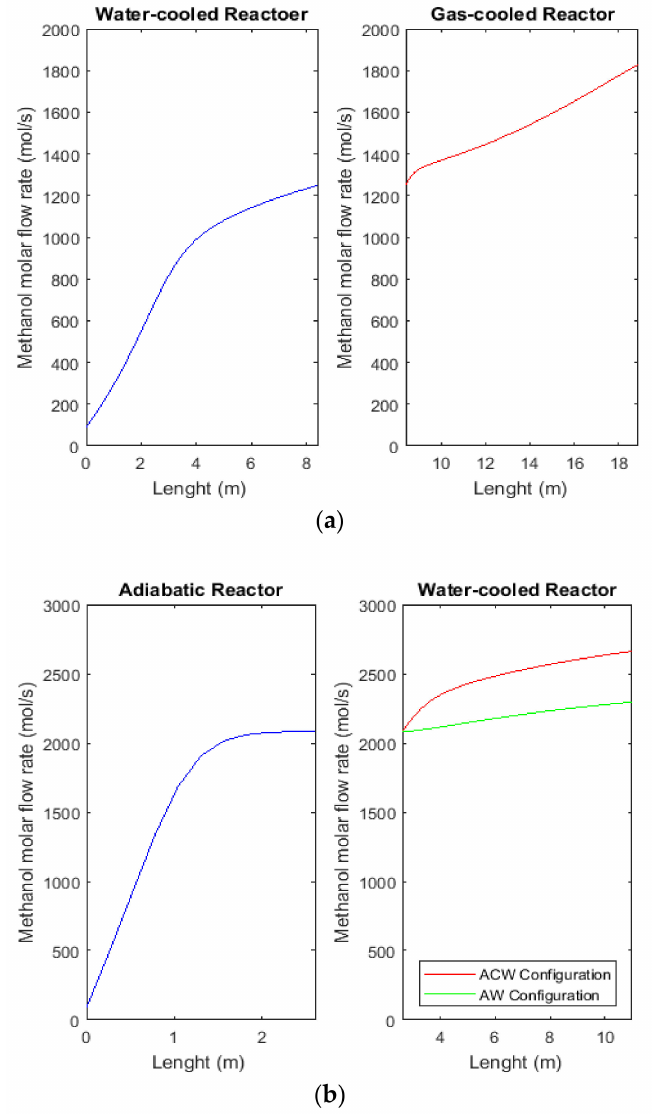
Figure 5. Methanol molar flow rate along reactors in ( a ) CR configuration; and ( b ) AW and ACW